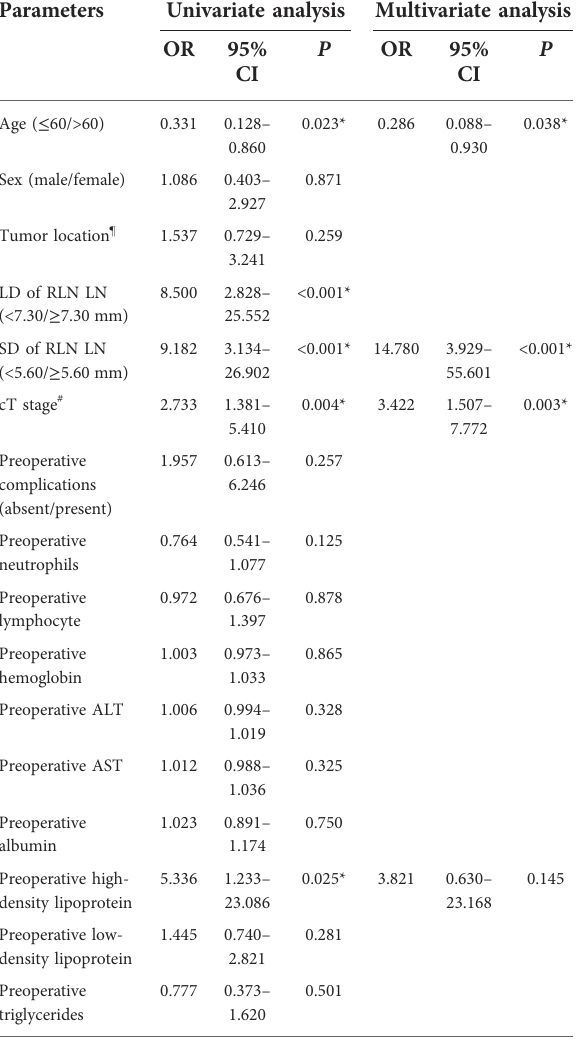
TABLE 2 Univariate and multivariate analyses for risk factors of left RLN LNM.